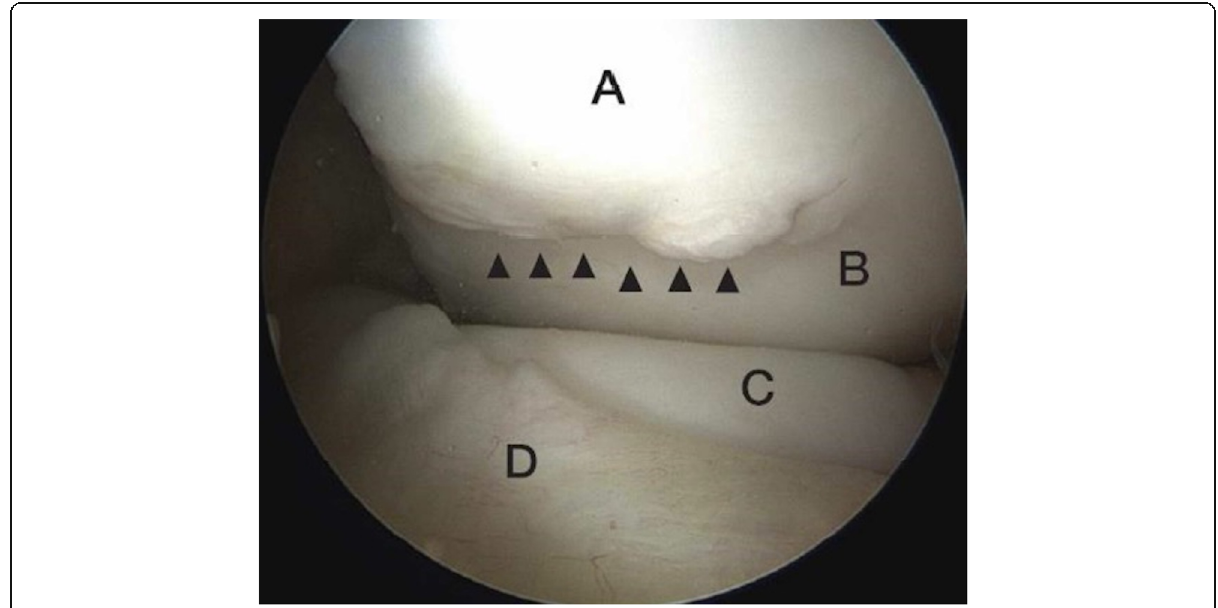
Fig. 4 View of anterior medial compartment showing impingement lesion of the medial femoral condyle. a Impingement Lesion, b Normal Femur, c Normal Anterior Tibia, d Anterior Horn of Medial